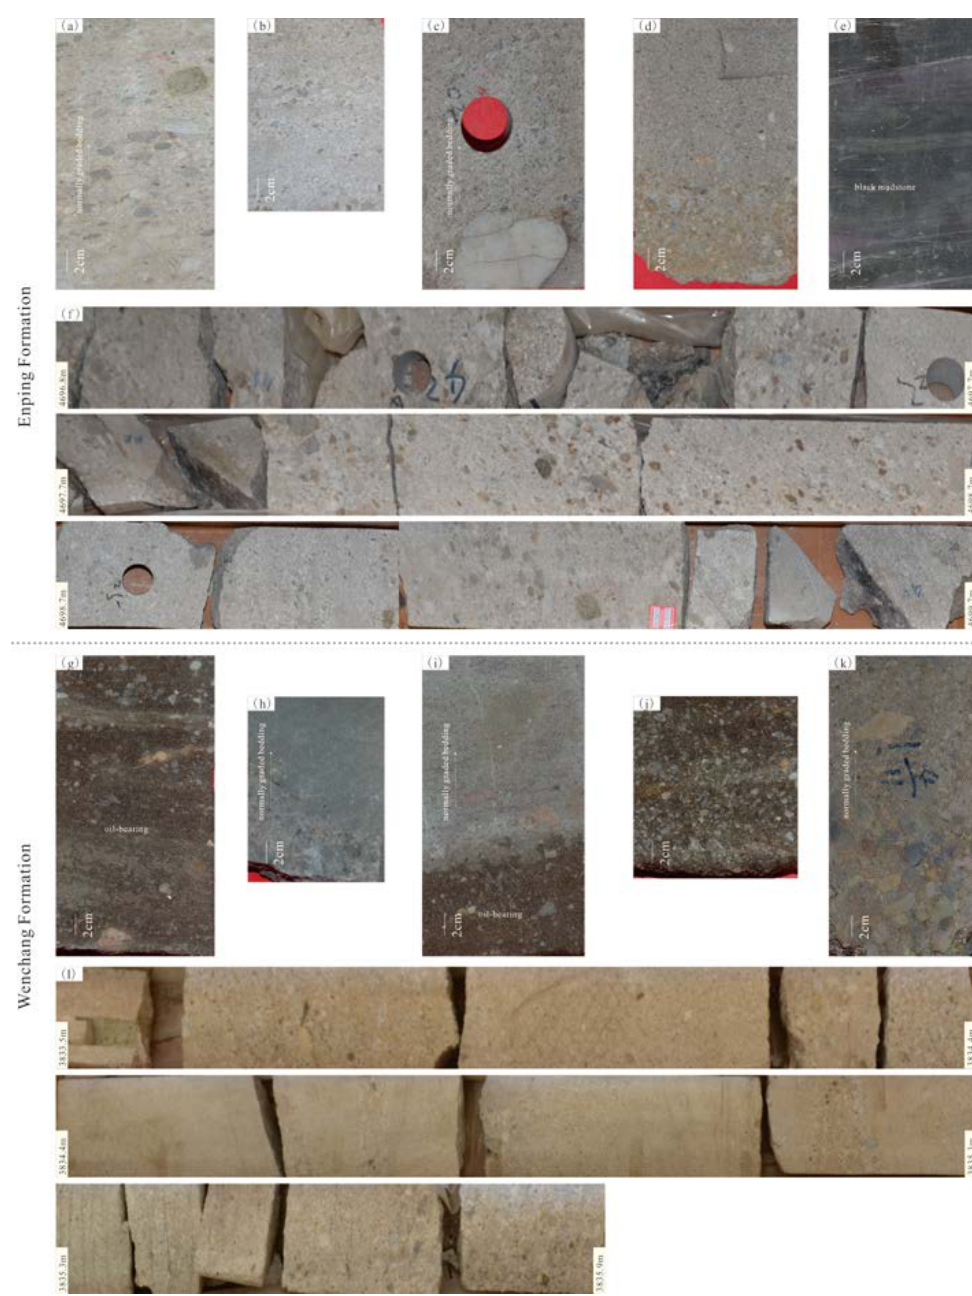
Figure 4. Typical sedimentary characteristics of the deposits in the Enping ( a – f ) and Wenchang ( g – l ) Formations in the Zhu III Depression: ( a ) 4694.4 m in Well W1, gravelly sandstone with normally graded bedding; ( b ) 4698.1 m in Well W1, gravelly sandstone; ( c ) 4695.4 m in Well W1, gravelly sandstone with normally graded bedding; ( d ) 4693.2m in Well W1, gravelly sandstone with normally graded bedding; ( e ) 4694.6 m in Well W1, black mudstone; ( f ) 2.9 m (4696.8–4699.7 m) long core of the underwater distributary channels of the fan deltas; ( g ) 4042.9 m in Well W13, oil-bearing gravelly sandstone; ( h ) 3830.0 m in Well B3, gravelly sandstone with normally graded bedding; ( i ) 3041 m in Well W12, oil-bearing gravelly sandstone with normally graded bedding; ( j ) 3043 m in Well 13, oil-bearing gravelly sandstone; ( k ) 3581 m in Well W9, gravelly sandstone; ( l ) 2.4 m (3833.5–3835.9 m) long core of the underwater distributary channels of the fan deltas.